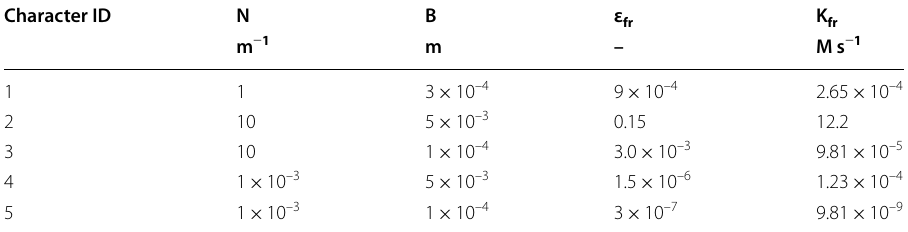
Table 2 Values used for fracture densities from 1 × 10 –3 to 10 m − 1 and fracture apertures 1 × 10 –4 to 5 × 10 –3 m used to assess model